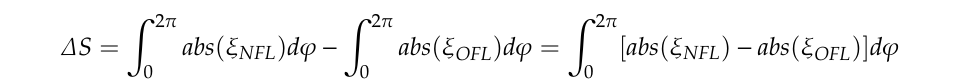
Figure 8. Distribution of air gap flux lines of motor.